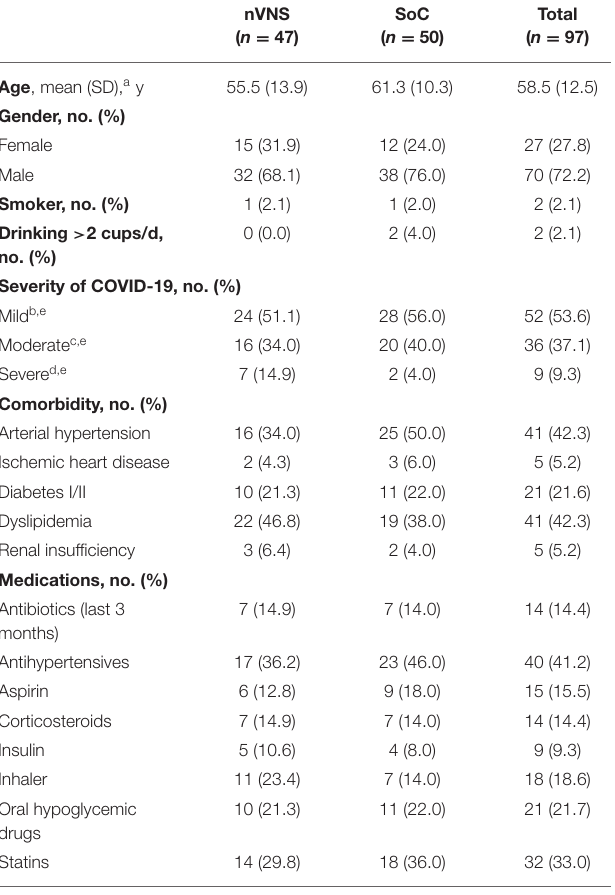
TABLE 3 | Participant demographics, baseline characteristics, and relevant medical history.